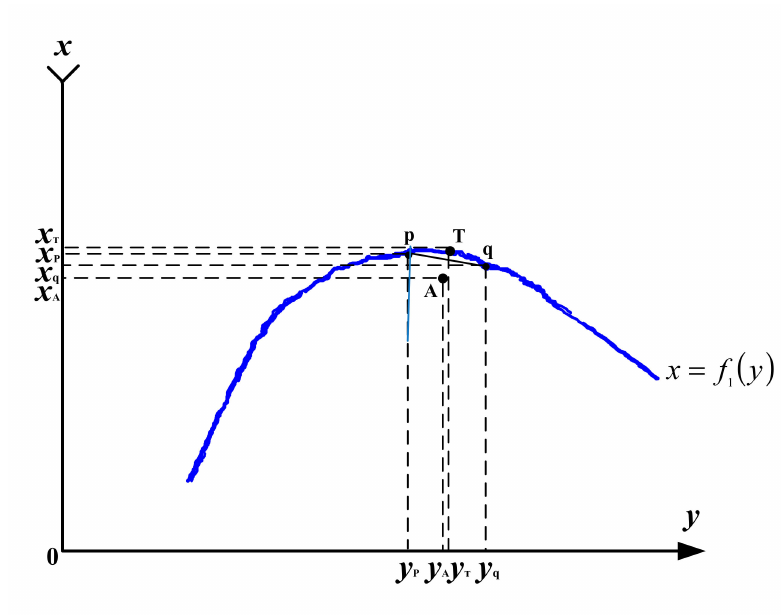
Figure 2. Typical configuration of the natural disaster zone